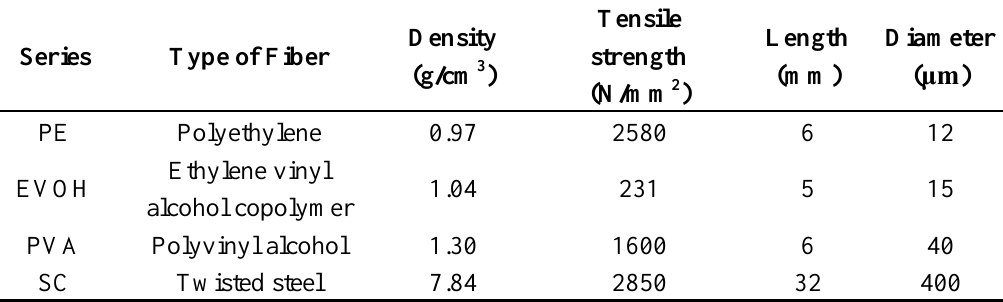
Table 2. Properties of employed fibers.